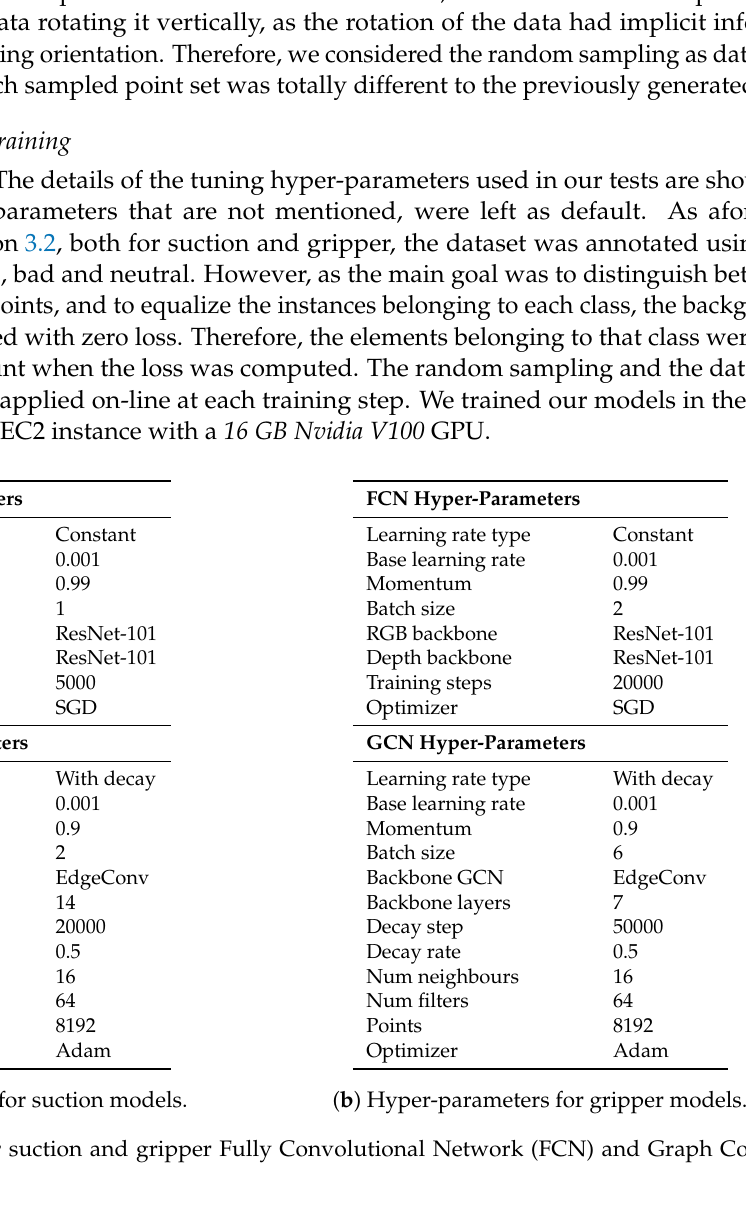
points and pink for neutral points. 514